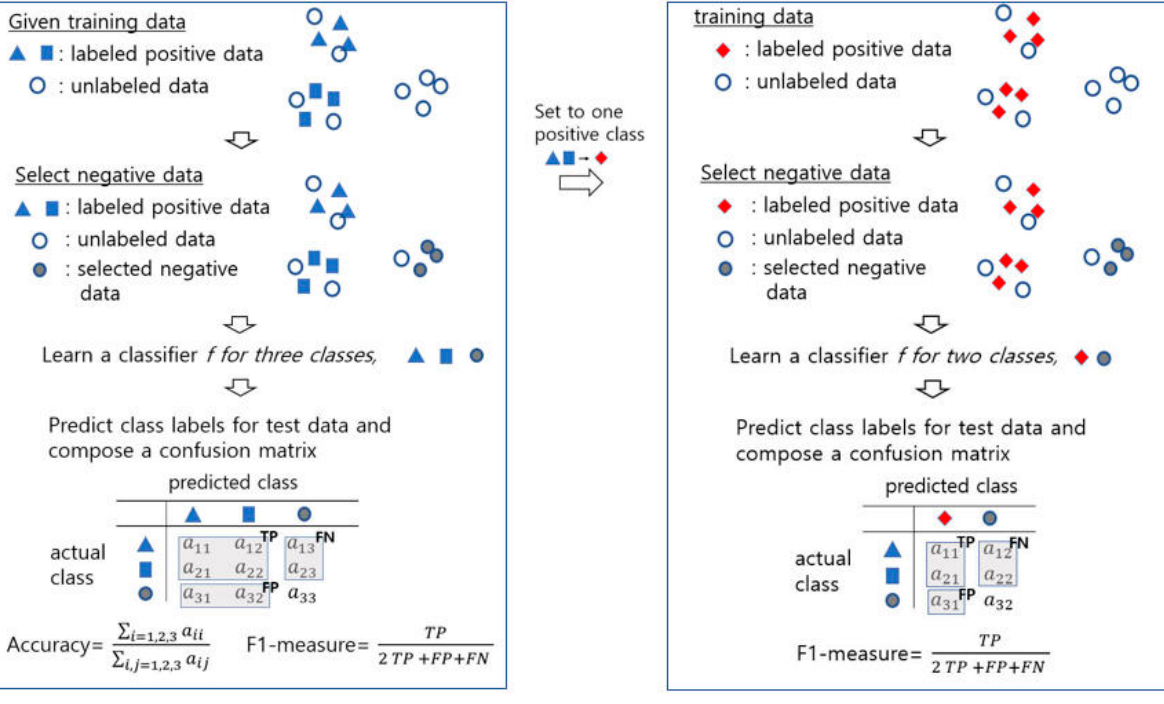
Table 2. Performance comparison by accuracy and F1-measure.